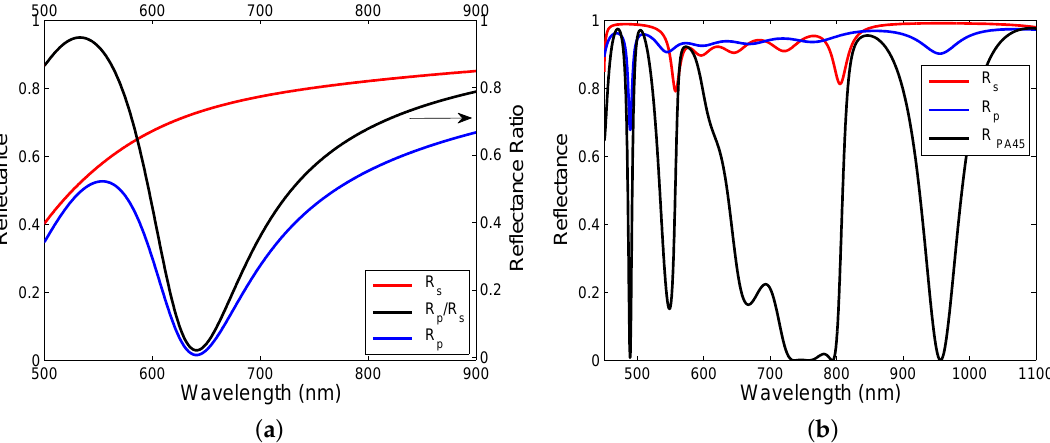
Figure 4. Theoretical spectral reflectances R s ( λ ) and R p ( λ ) , respectively, for the multilayer structures: the MPS and the reflectance ratio R p ( λ ) / R s ( λ ) ( a ), the MDS and the reflectance R PA45 ( λ ) ( b ). Analyte is